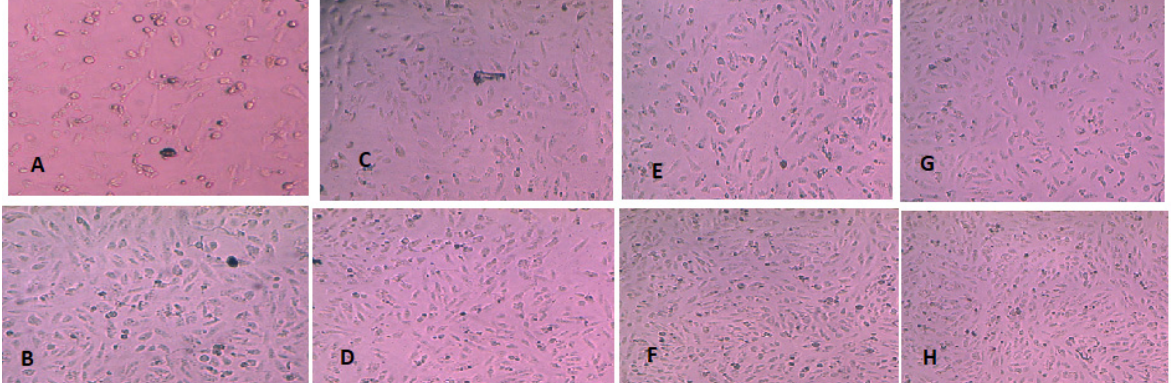
Figure 5. The cytotoxicity of different AgNPs concentrations produced by Streptomyces aizuneusis against liver carcinoma cell line detected by NRU colorimetric technique. The images were taken using microscopy at 100×. ( A ) negative control, ( B ) positive control, ( C ) cells treated with 0.01 ppm, ( D ) cells treated with 0.02 ppm, ( E ) cells treated with 0.04 ppm, ( F ) cells treated with 0.06 ppm, and ( G ) cells treated with 0.08 ppm and ( H ): cells treated with 0. 1 ppm.